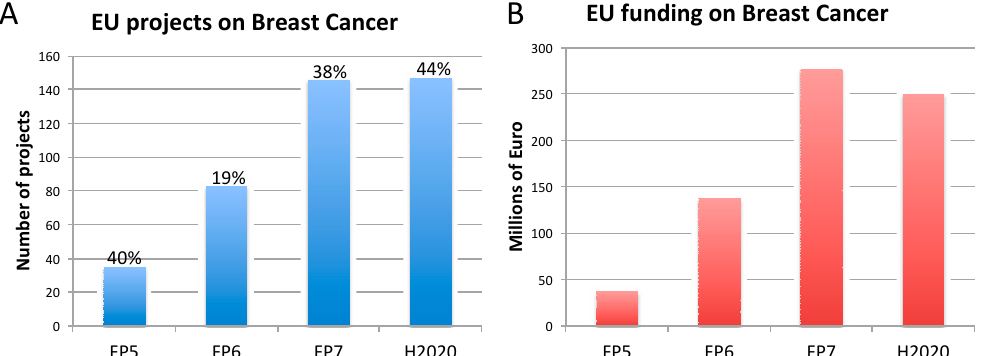
Figure 1. Number of EU-funded projects ( A ) and overall funding (in millions of euro) ( B ) allotted on Alzheimer’s disease-related research across Framework Programme (FP) 5, FP6, FP7 and Horizon 2020 (H2020). The percentages indicate the proportion of projects within a Framework Programme involving also the use of non-human animal models. Data were obtained from CORDIS [128], considering objective, reporting, and results sections, to assess whether non-human animal models were accounted for (H2020 data, as of 10 April 2020). As H2020 was still ongoing at the time of this analysis, H2020 data are not complete.